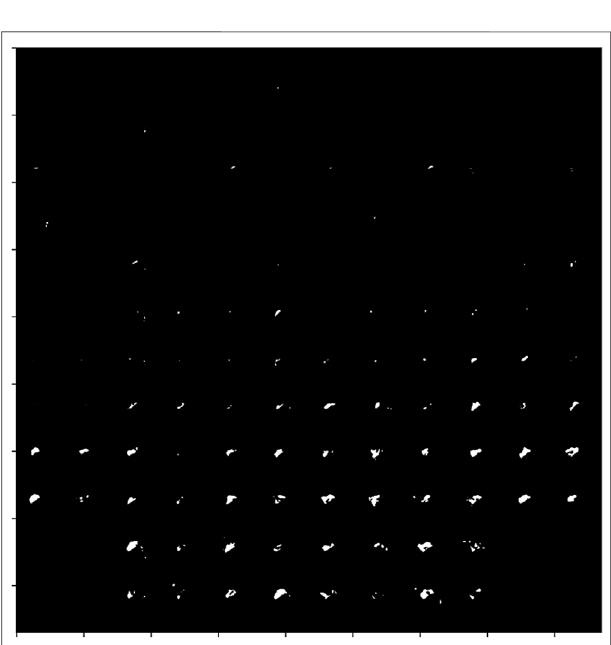
FIGURE 4 | Binary class labels for “ Soot ” for each voxel of the build chamber in layer 10 of build 1 as predicted by Peregrine.